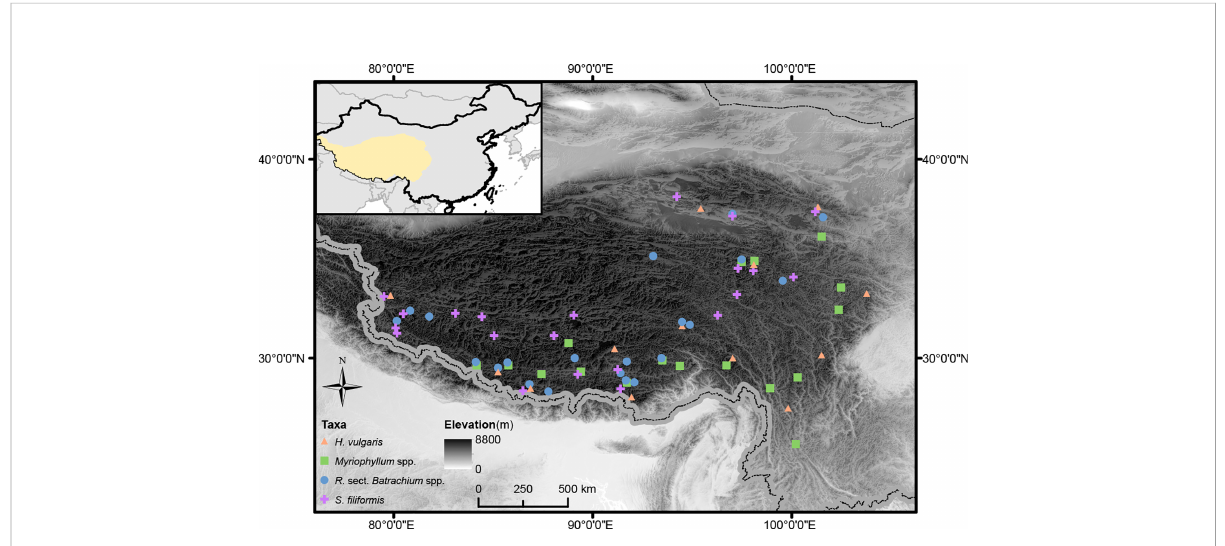
FIGURE 1 Geographic distribution of study sites for target taxa on the Qinghai-Tibetan Plateau. The elevation of the study region is visually